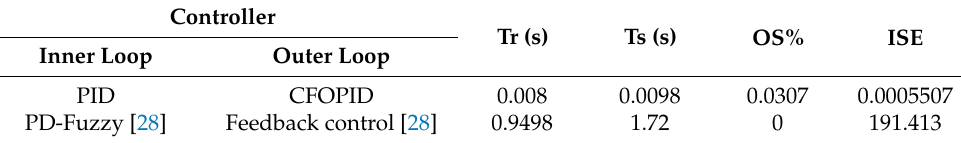
Figure 17. The CFOPID and PID controllers’ responses with varying setpoint. Table 7. The optimal values of the CFOPID and FOPID